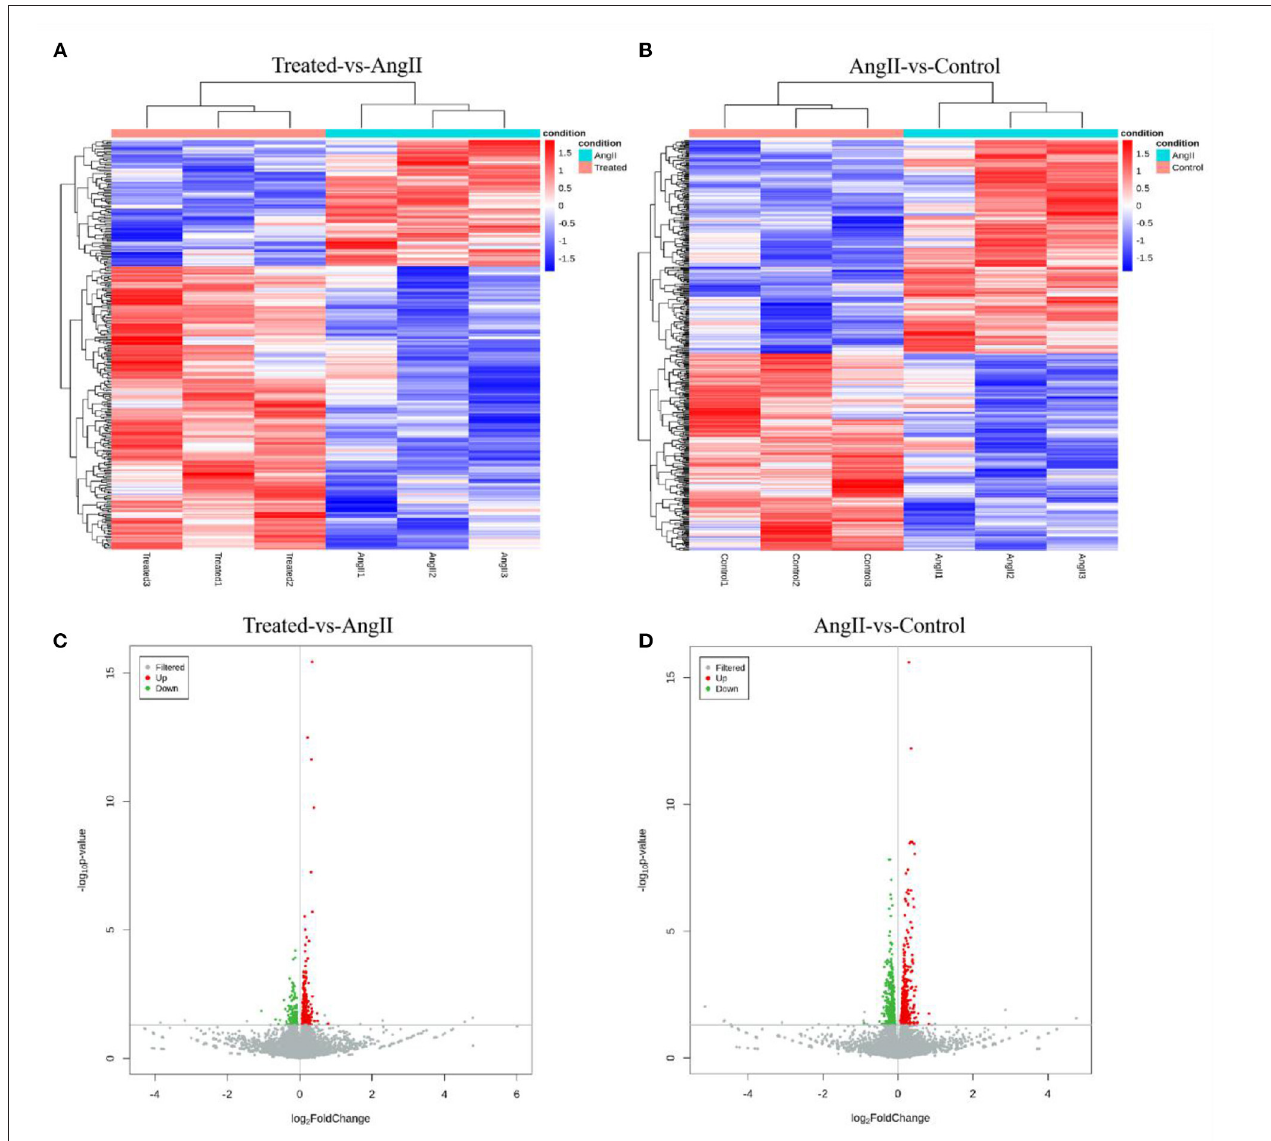
FIGURE 6 | Transcriptome gene expression altered in the VSMCs. (A) Hierarchal clustering of differentially expressed genes (DEGs) in FPQYLQYPY treated group and Ang II-treated group. (B) Hierarchal clustering of differentially expressed genes (DEGs) in Ang II-treated group and control group. (C) The volcano map of differentially expressed genes (DEGs) in FPQYLQYPY treated group and Ang II-treated group. (D) The volcano map of differentially expressed genes (DEGs) in Ang II-treated group and control